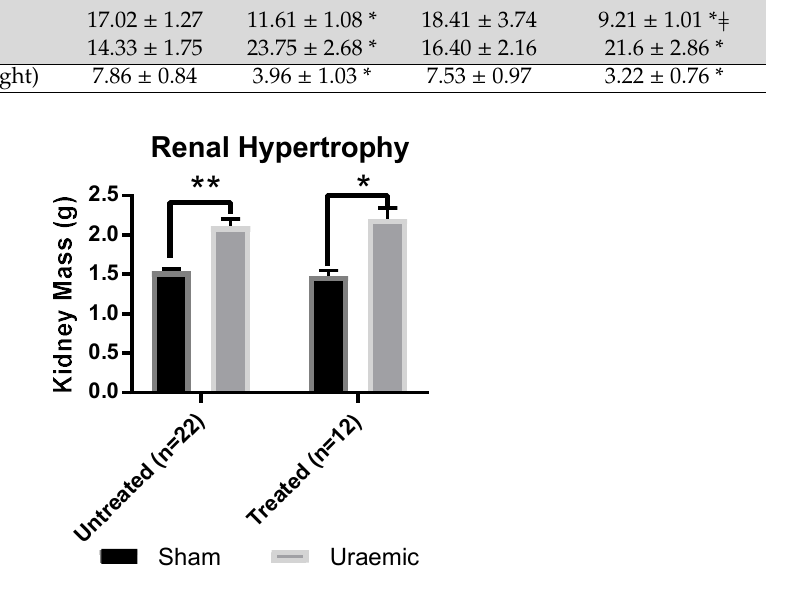
Figure 1. Renal hypertrophy in uraemic and sham animals ( n = 22) and in animals exposed to intravenous (iv) iron therapy at six weeks was assessed by measuring left kidney mass. Data are presented as mean ± SEM, (* p < 0.05 and ** p < 0.01).